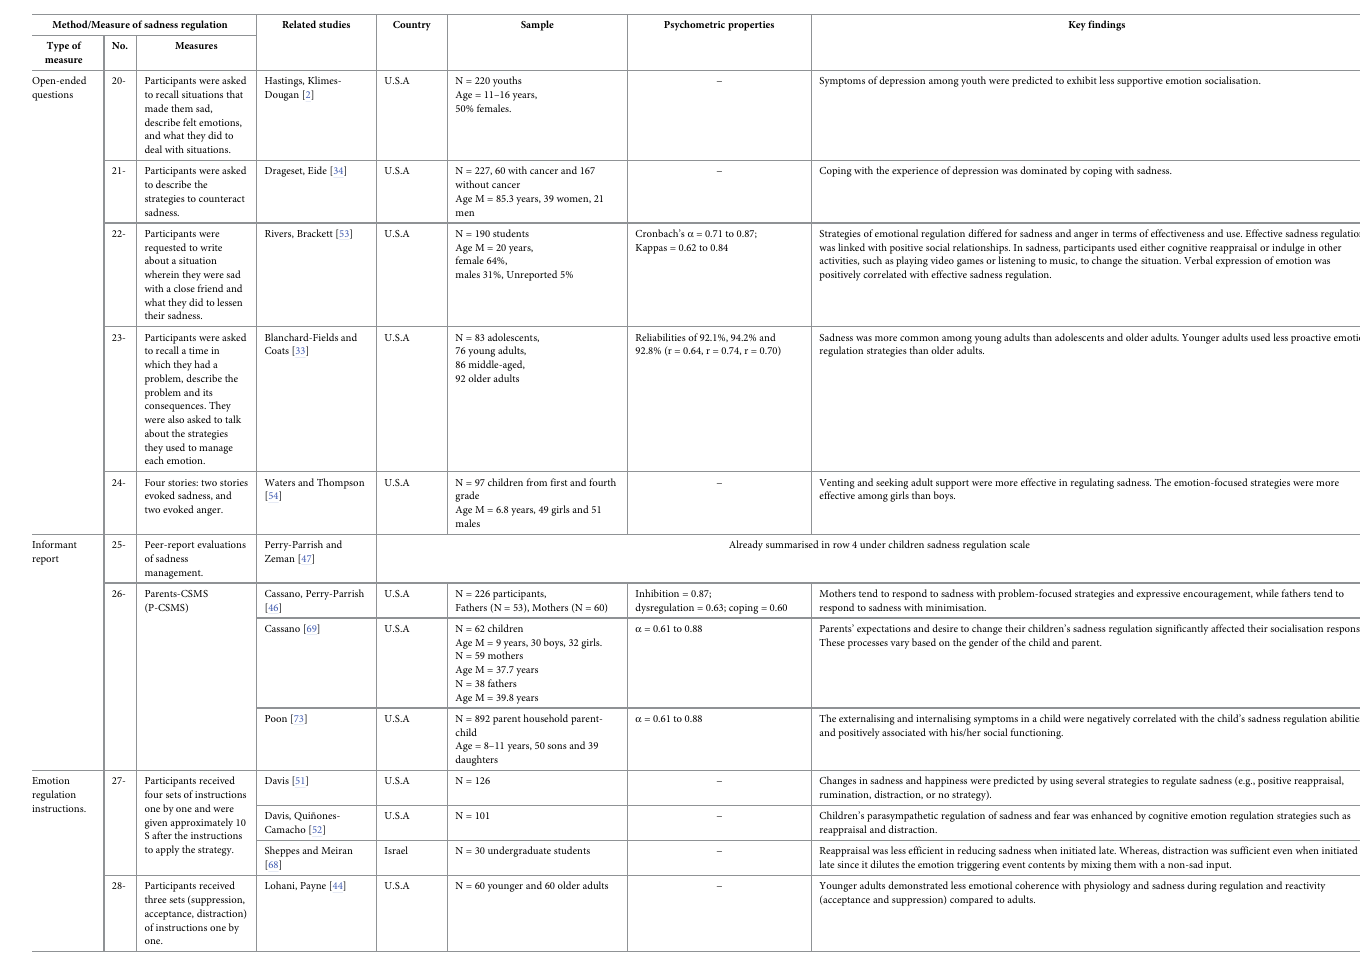
assessment table. As for structural validity, five studies reported adequate study quality by including exploratory factor analysis (EFA) that identifies the factors of structure for new instrument without prior hypothesis [77]. Four studies reported confirmatory factor analysis (CFA) that tests the structure of hypothesised factors [78]. Only two instruments (CSMS and Anger & Sadness Self-regulation Scale) assessed cross-cultural validity. All the studies, except for three, did not provide any data on reliability. Meanwhile, only Zeman and Shipman [66] developed a questionnaire to measure sadness regulation among children. retrieved from the selected articles were evaluated against the criteria for good psychometric properties. Table 4 summarises the rating of each psychometric property, while Table 5 pres- ents the overall rating and quality of evidence of each psychometric property. Findings from each study were rated as sufficient (+), insufficient (-) or indeterminate (?). Two instruments (CSMS and CIRE-43) reported indeterminate structural validity because they used less robust EFA that reported incomplete information about the structural validity of the measures. Meanwhile, SERIS and Anger and Sadness Self-regulation Scale instruments were rated as insufficient because the criteria for sufficient or for good structural validity were not